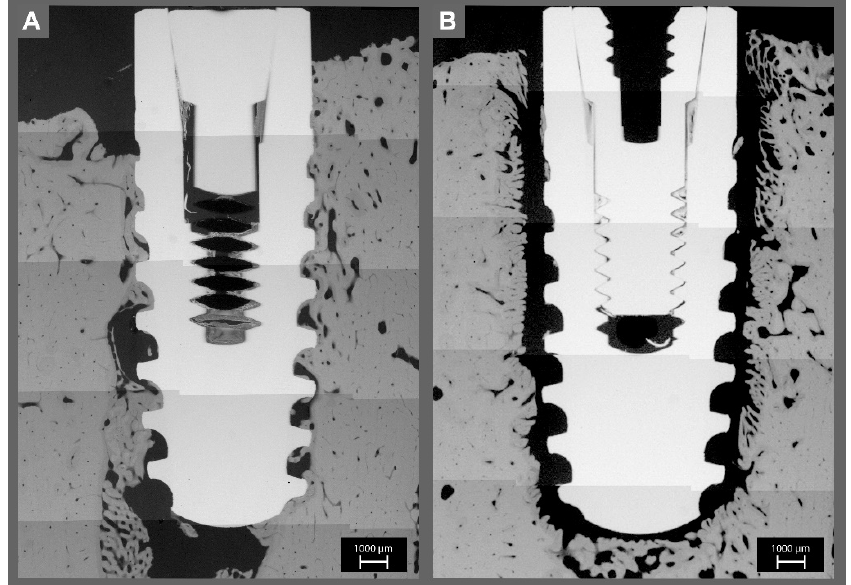
Figure 6. The radiological examination of the same samples of ( A ) sterile and ( B ) contaminated im- plants inserted into the basis mandible. Please note the lack of osseointegration around the contam- inated implant.